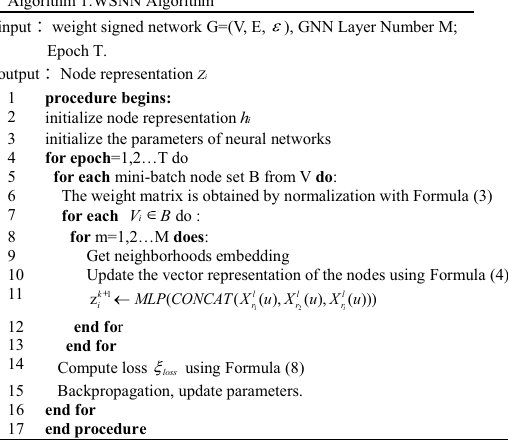
Algorithm 1:WSNN